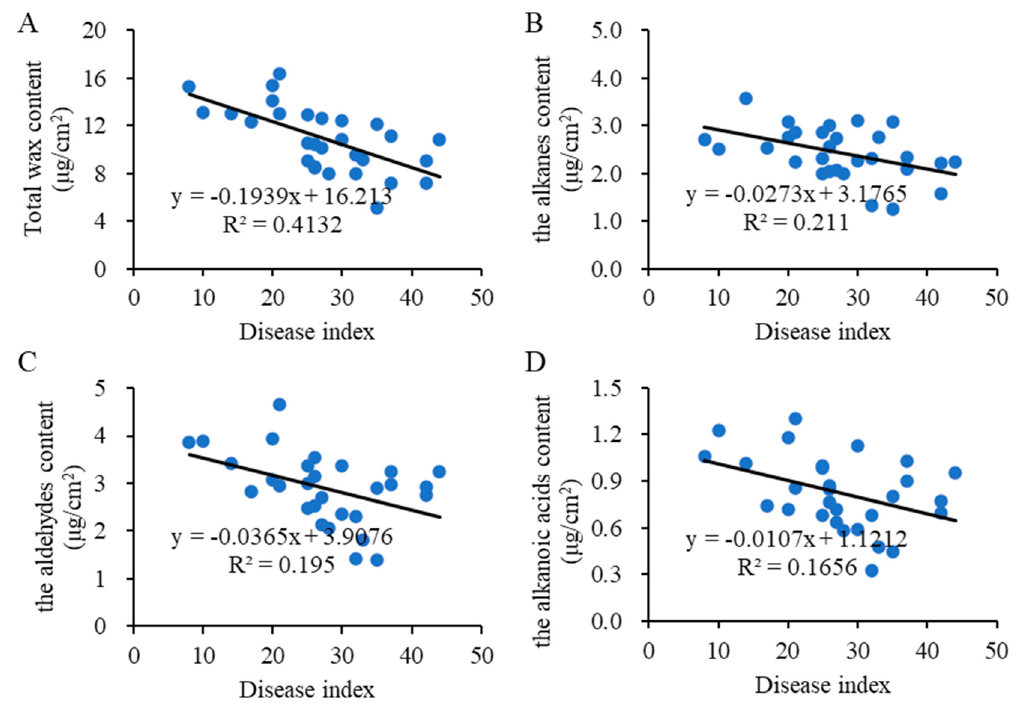
Figure 8. Correlation analysis between wax content and disease index. ( A ) Correlation analysis between total wax content and disease index. ( B ) Correlation analysis between alkanes content and disease index. ( C ) Correlation analysis between aldehydes content and disease index. ( D ) Correlation analysis between alkanoic acids content and disease index.